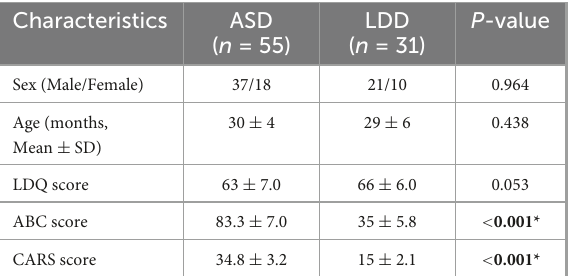
TABLE 1 Participant characteristics discriminated according to autism spectrum disorder (ASD) or language developmental delays